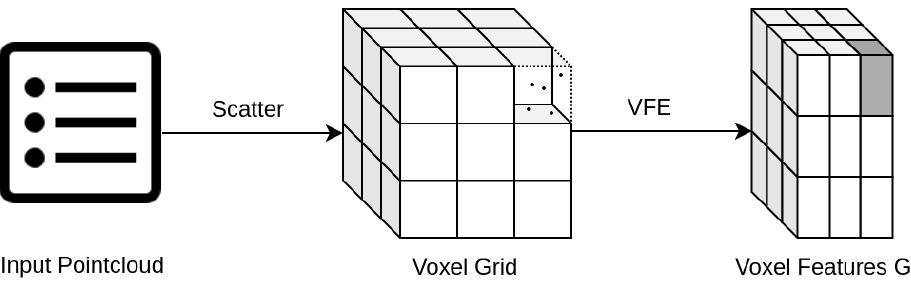
Figure 2. Input LiDAR pointcloud voxel-wise processing. After scattering all points into correspond- ing cells, a VFE network yields the initial feature vector for each voxel separately. The dense nature of Voxel Feature Grid (even if filled with zeros when the voxel is empty) enables further layers to be processed in a convolutional